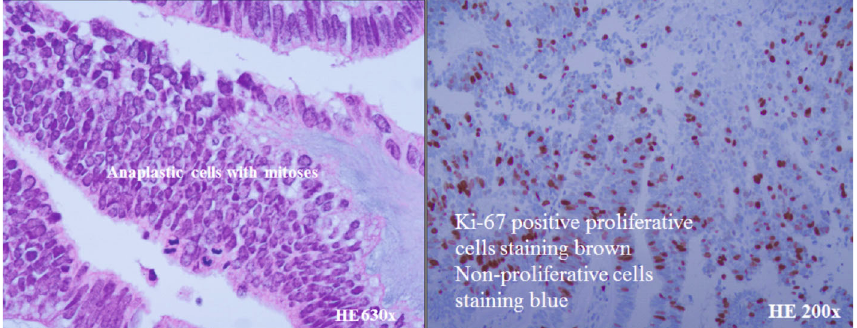
Figure 2: Anaplastic cells with mitosis and Ki-67-positive proliferative cells are shown. The cells are stained positive for S-100, CD56, and factor VIII (not shown in these fi gures). The rapid growth indicated by positive Ki-67, a proliferating marker, and the presence of anaplastic cells were the main reasons for the diagnosis of malignant medulloepithelioma. HE(S): hematoxylin-eosin (sa ff